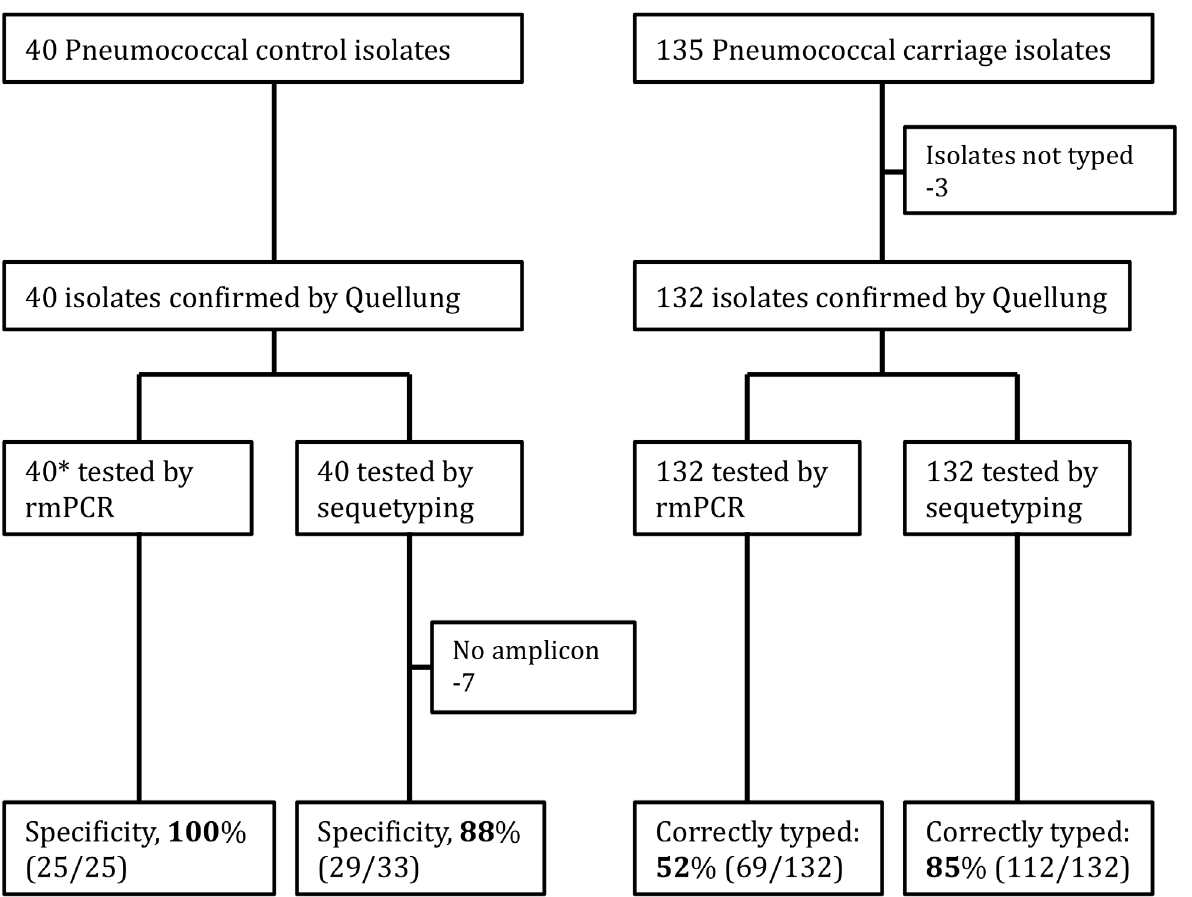
Fig 1. Flow chart showing the pneumococcal isolates included in the study. * Of the 40 isolates that were tested by rmPCR, only 25 were included as part of the rmPCR targets.